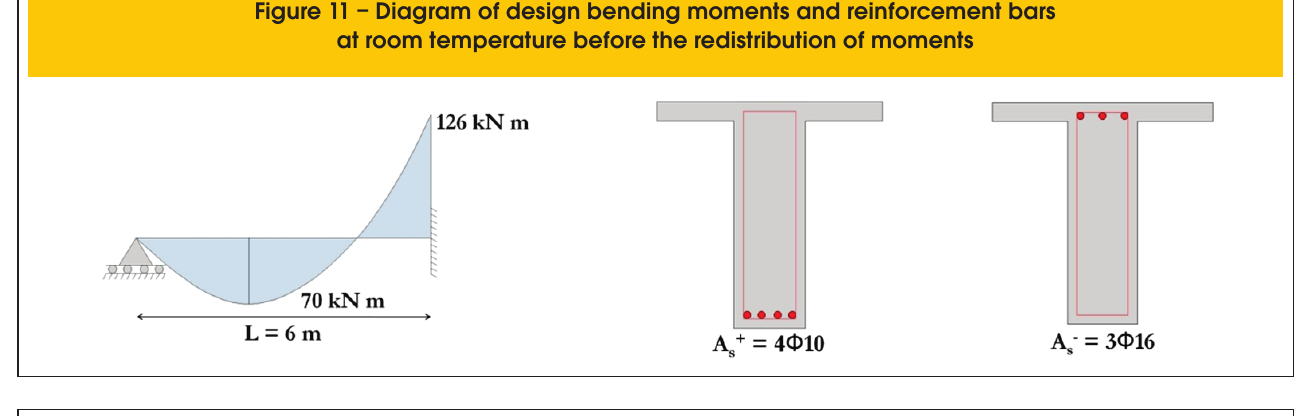
Figure 11 – Diagram of design bending moments and reinforcement bars at room temperature before the redistribution of moments